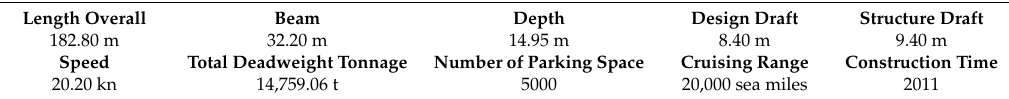
Table 1. Basic parameters of the